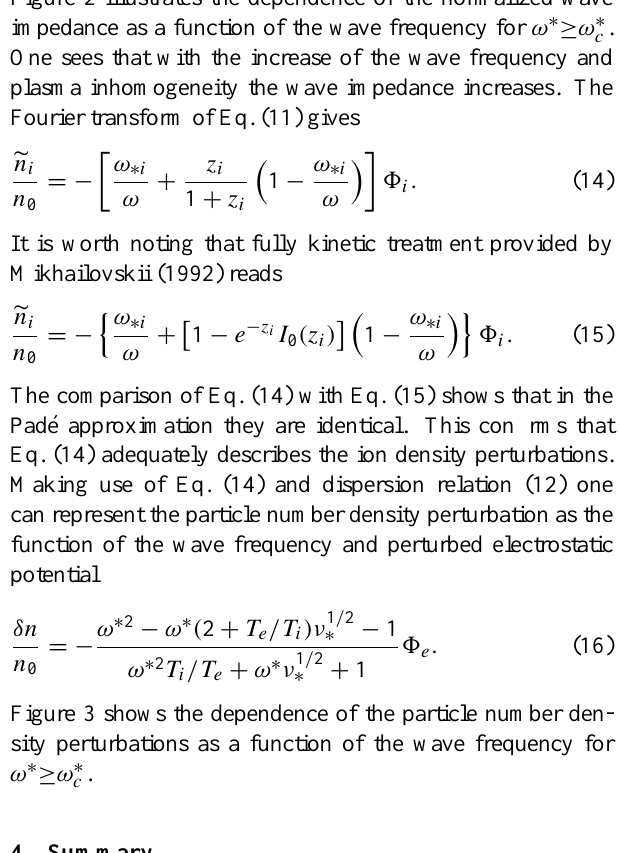
Fig. 4. The dependence of the perpendicular wave number nor- malized to the ion Larmor radius as a function of the normalized frequency. Calculations are carried out for the electron to ion tem- perature ratio T i /T e = 14. Solid, dash-dot, dashed lines correspond to ν ∗ = 0, 10, and 100,